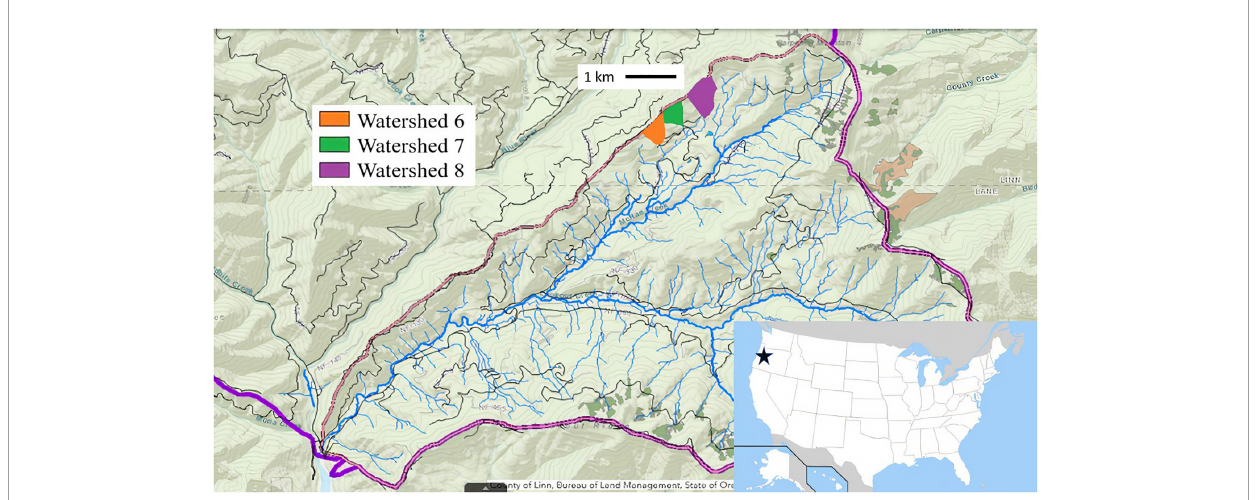
FIGURE1 Map of H. J. Andrews Experimental Forest—a Long Term Ecological Research Site (LTER) in Lane and Linn County, Oregon, USA. Includes coloration of three watersheds with different management histories that were sampled for soil fungi. Watershed 6, clearcut in 1974; watershed 7, canopy harvest in 1974, 1984, and thinning in 2004; watershed 8, unlogged.